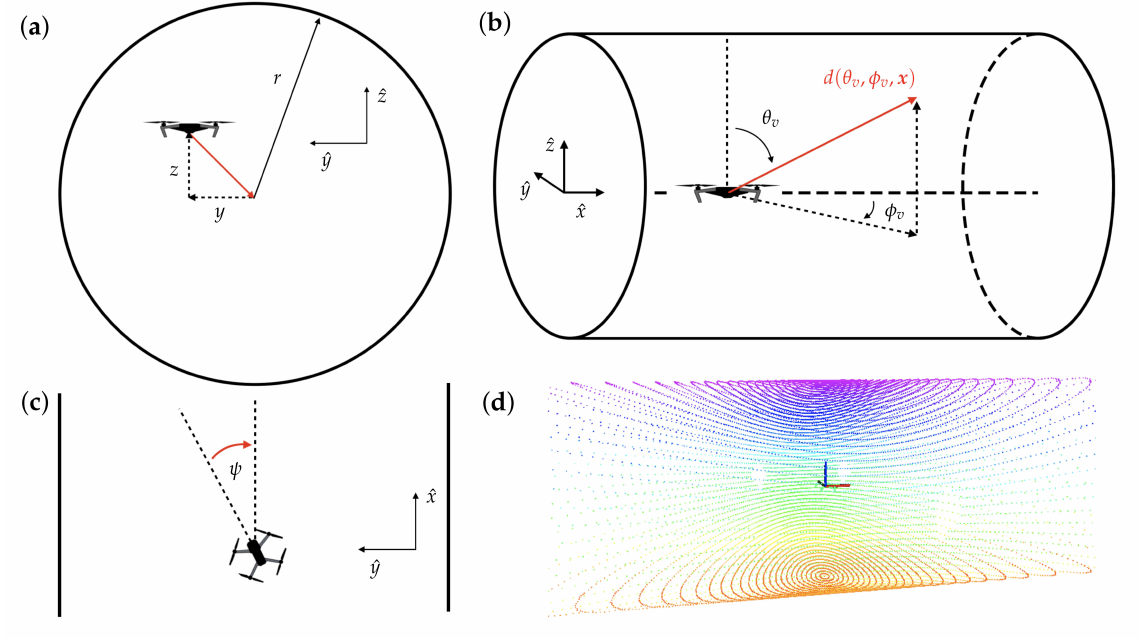
Figure 3. Different views of an infinite cylinder environment are shown with corresponding environ- ment relative variables. ( a ) View looking down cylinder. ( b ) Full 3D view of cylinder environment. ( c ) Top-down view of cylinder. ( d ) Example of a measured depth scan in a cylinder environment using spherical LiDAR sensor. The points are colored based on their z position, with warmer colors representing points below the x-y plane and cooler colors representing points above the x-y